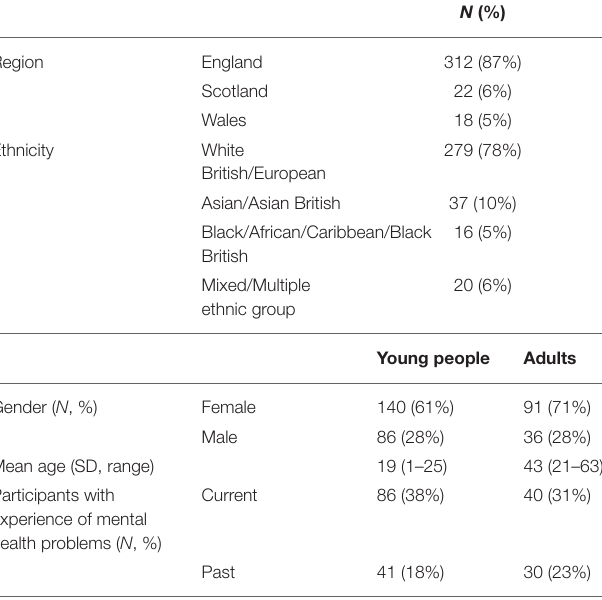
TABLE 2 | Public consultation survey sample